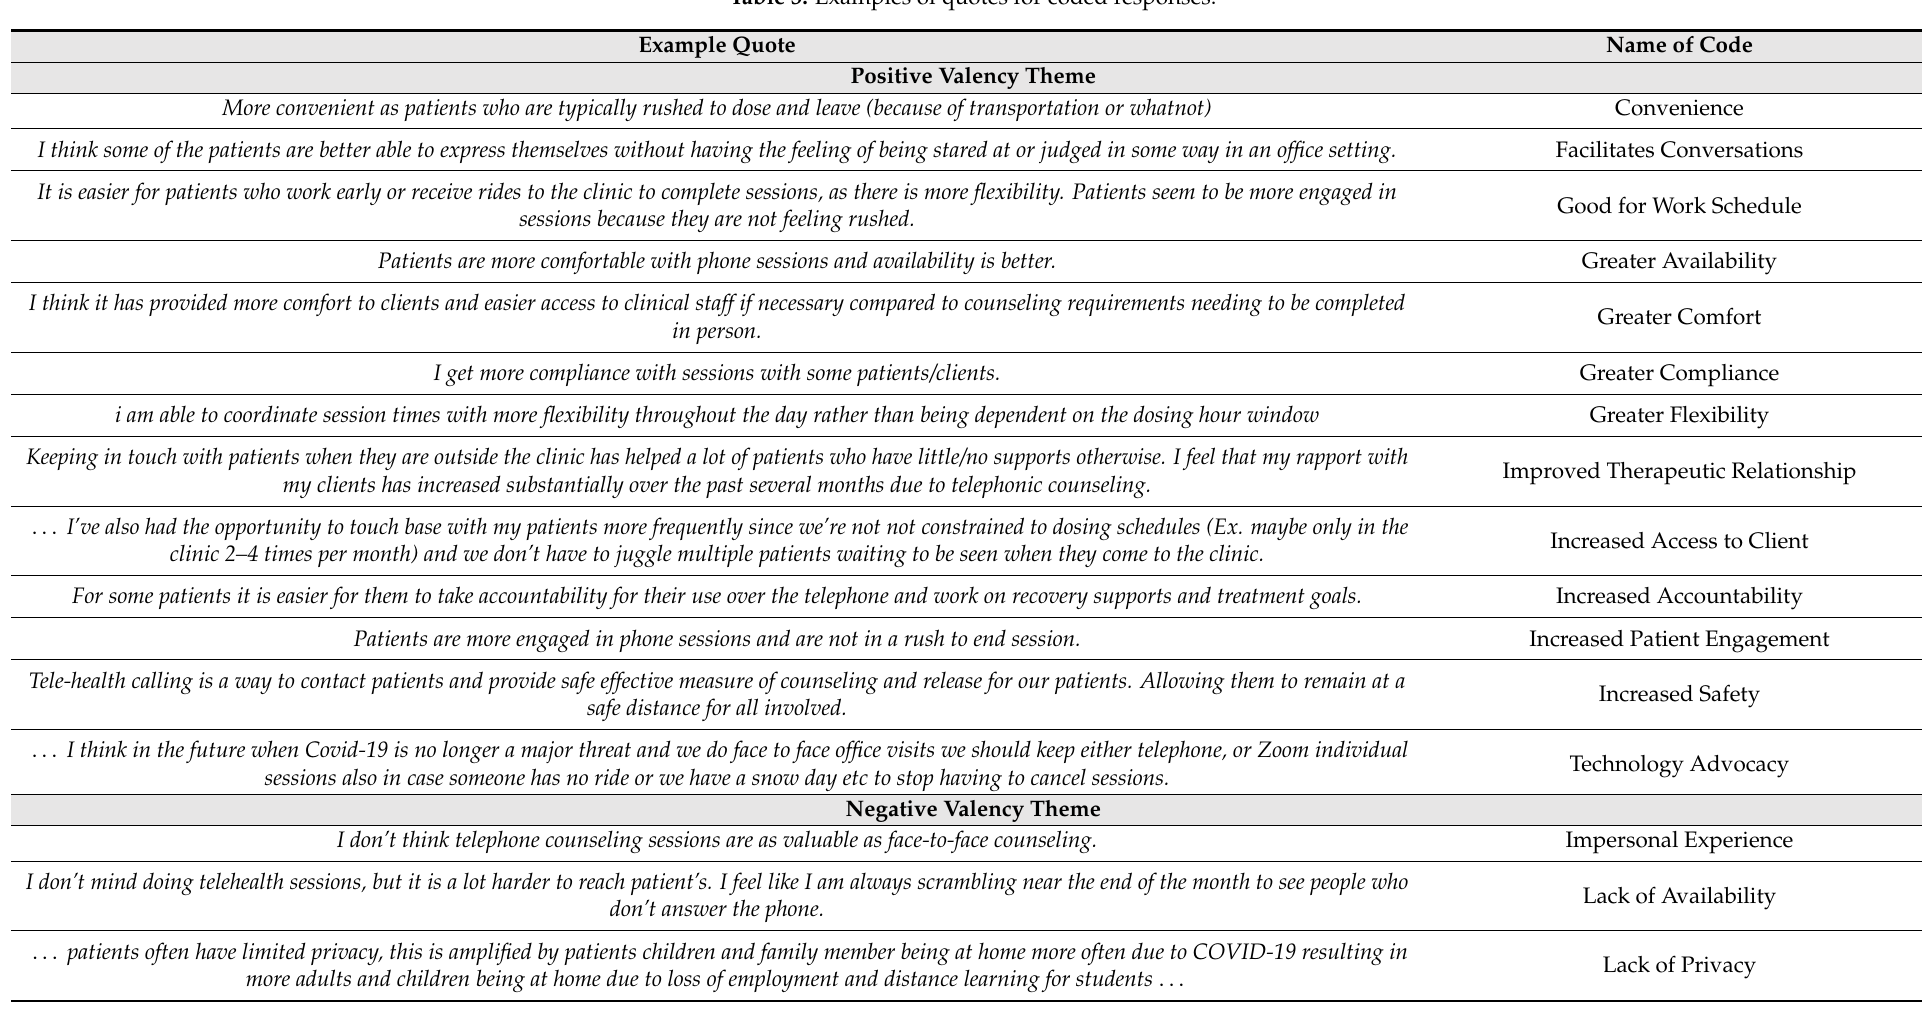
Table 3. Examples of quotes for coded